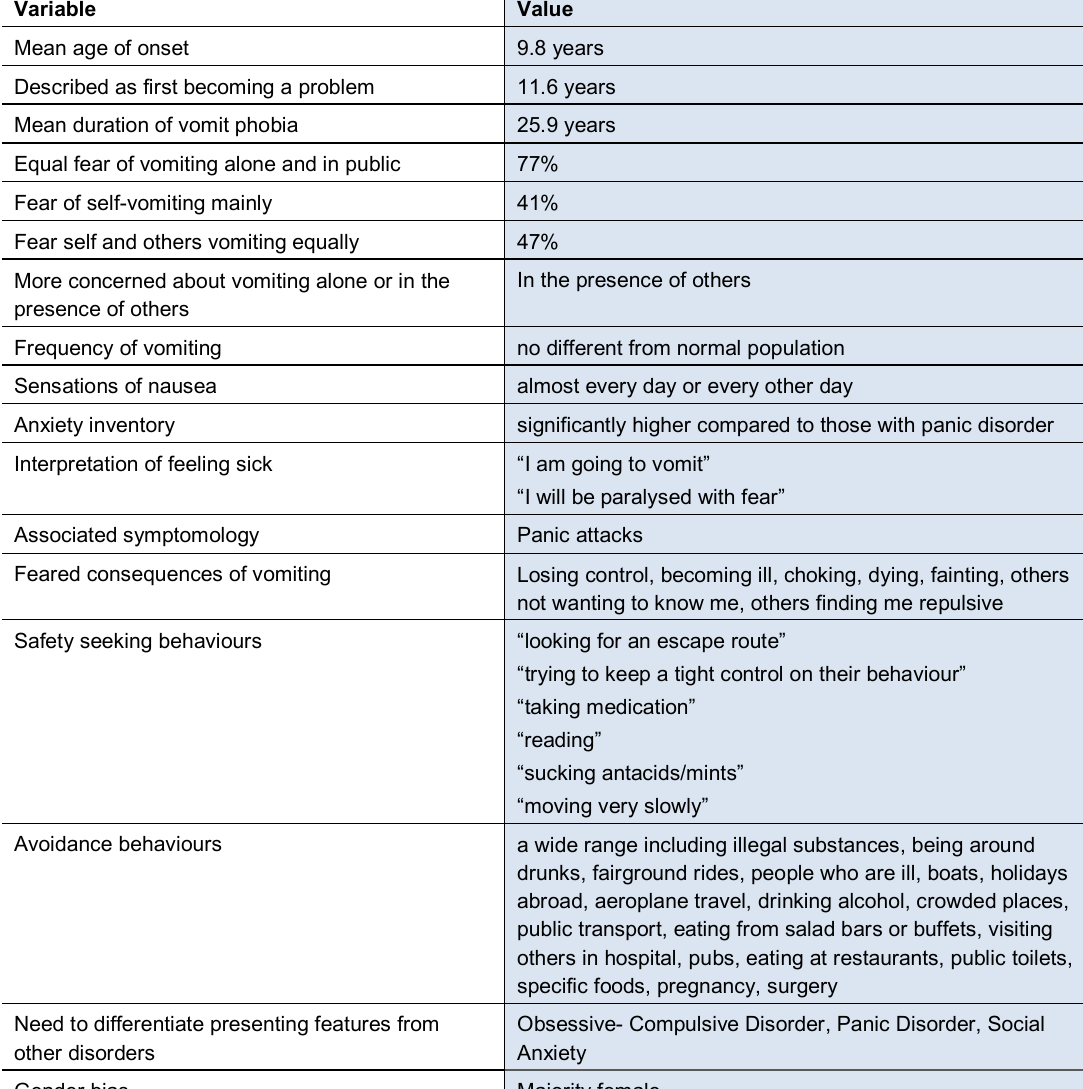
Table 1 – Clinical Picture of Emetophobia (Constructed from Lipsitz et al 2001 and Veale and Lambrou 2006)